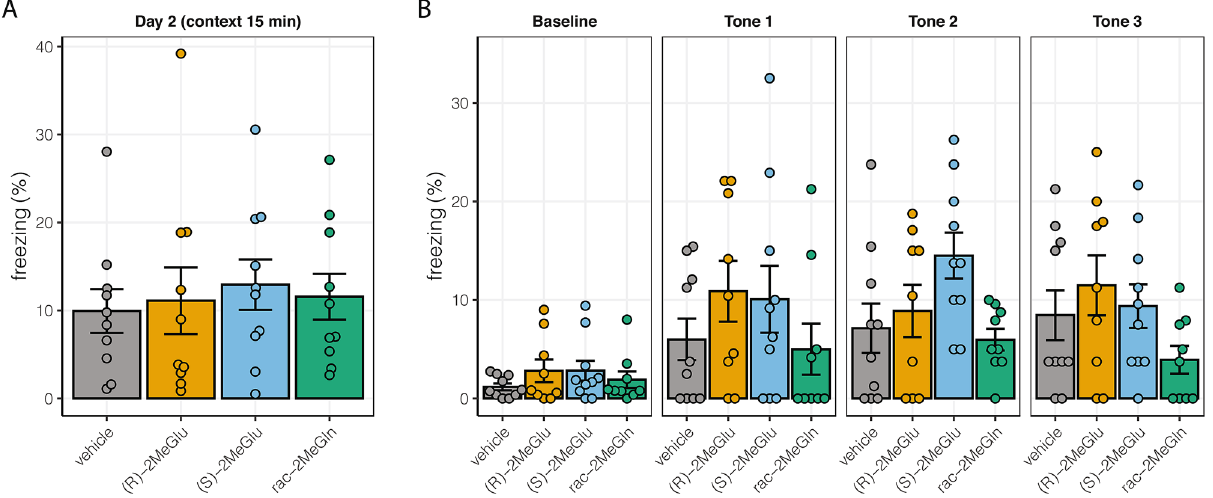
Figure 7. Behavioral effects of chronic 10 mg/kg/day IP dosing in 2 month-old male C57Bl/6 mice in fear conditioning tests on the fourth week of chronic exposure. ( A ) Freezing by the treatment group on Day 2 during contextual memory testing over 15 min. Data was not normally distributed. Kruskal–Wallis test had P approximately 0.7819. ( B ) Freezing at baseline and during each tone presentation on Day 3. Two-way repeated measures ANOVA had F Interaction (9, 102) = 1.313, P = 0.24; F Tone (3, 102) = 13.95, P < 0.0001; and F Exposure (3, 34) = 2.015, P = 0.13. All bars represent mean ± SEM, n = 10 mice per